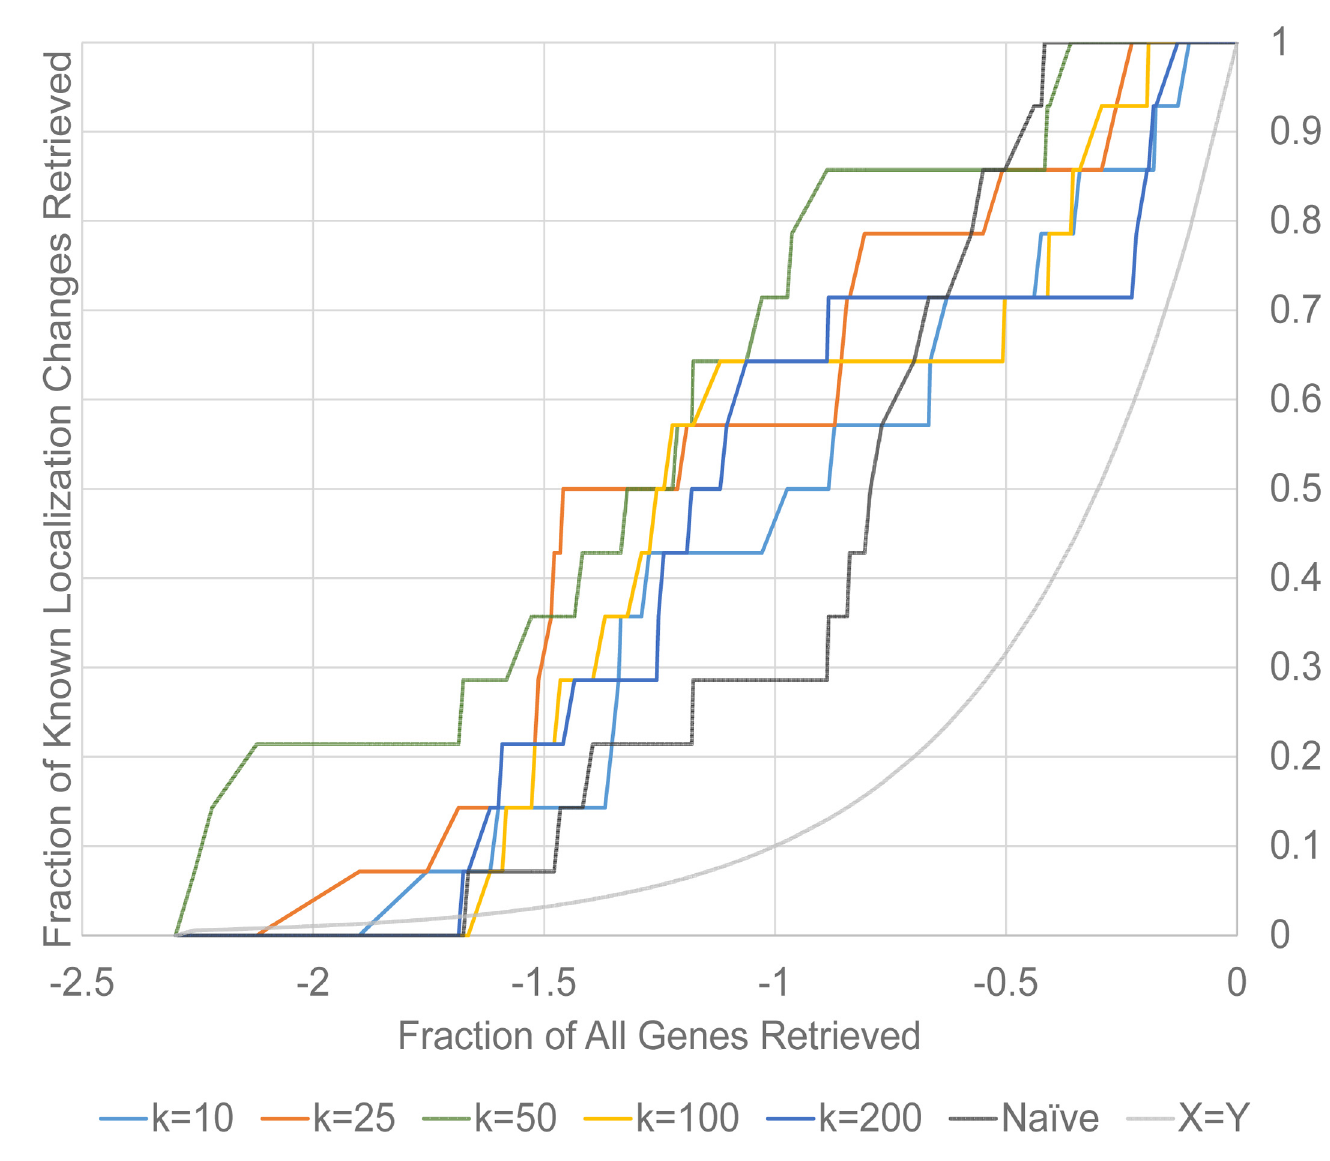
Fig 4. Fraction of known localization changes retrieved against the log 10 of fraction of all genes retrieved for the k NN method for k = 10, 25, 50, 100 and 200, respectively. We also show the na ï ve method and the x = y curve for